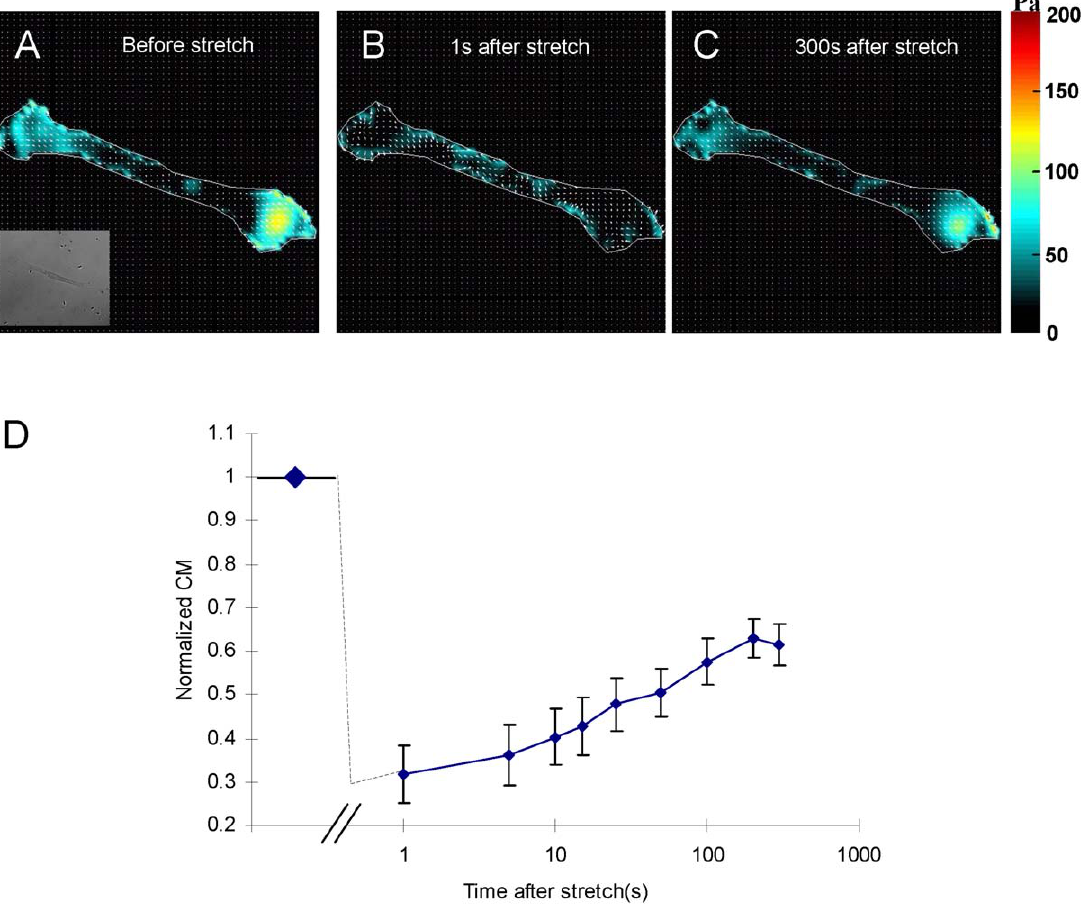
Figure 1. Traction force dynamics in HBSM cells subjected to a transient stretch. (A) Cell traction map before stretch. (B) Traction map immediately after a 10% homogeneous biaxial tensile stretch of a 4s duration. The cell tractions are markedly ablated. (C) Traction map measured